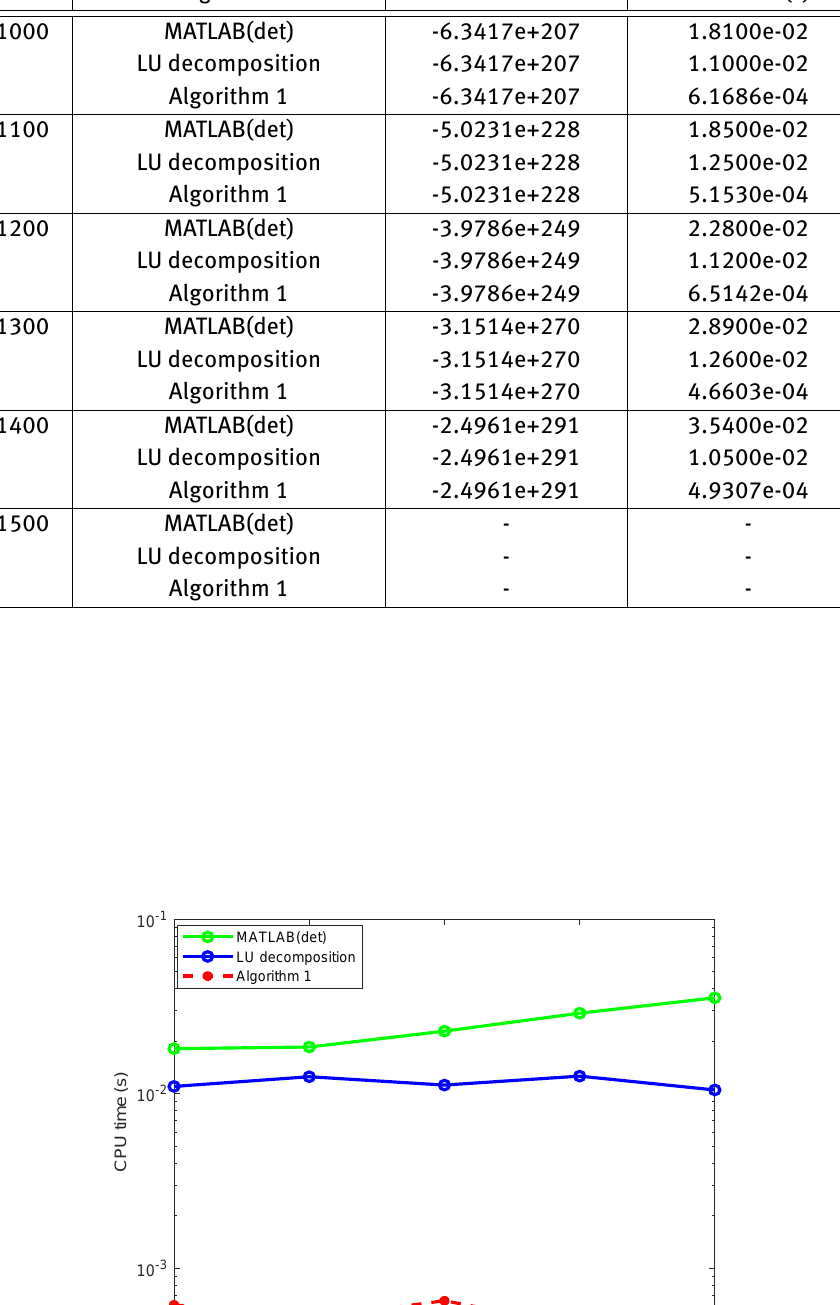
Table 3: The CPU time comparison for computing the determinant of Algorithm 1, the method in MATLAB and LU decomposition. n